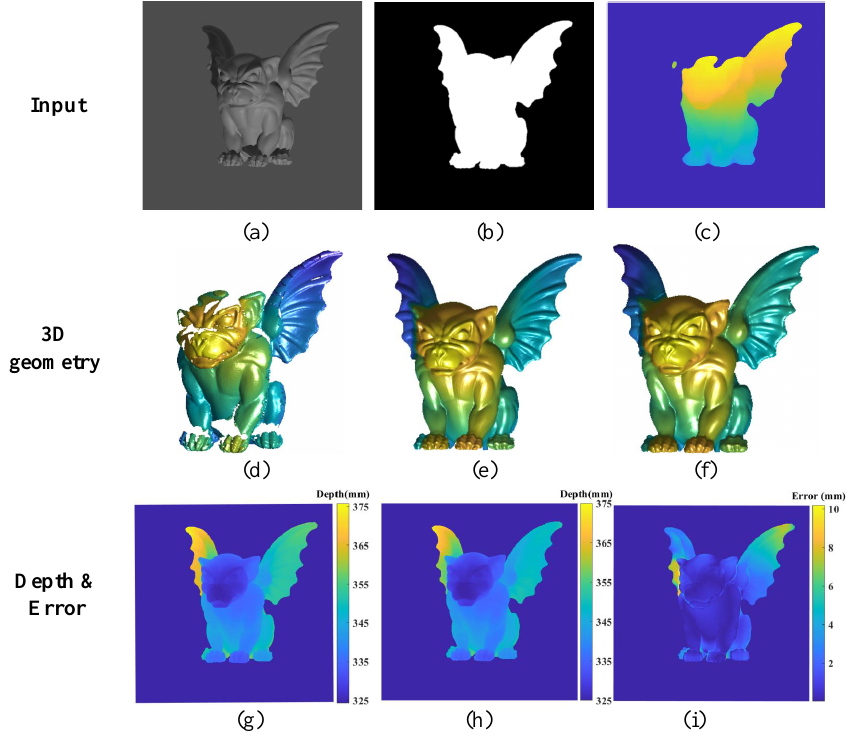
Figure 4. Results of an object from the virtual scanning. ( a – c ) The input of the texture image, the mask, and the phase map; ( d – f ) 3D geometry from FPP, the ground truth, and the prediction; ( g ) The ground truth of the depth map; ( h ) The predicted depth map; ( i ) The absolute error map with RMSE 2.6485